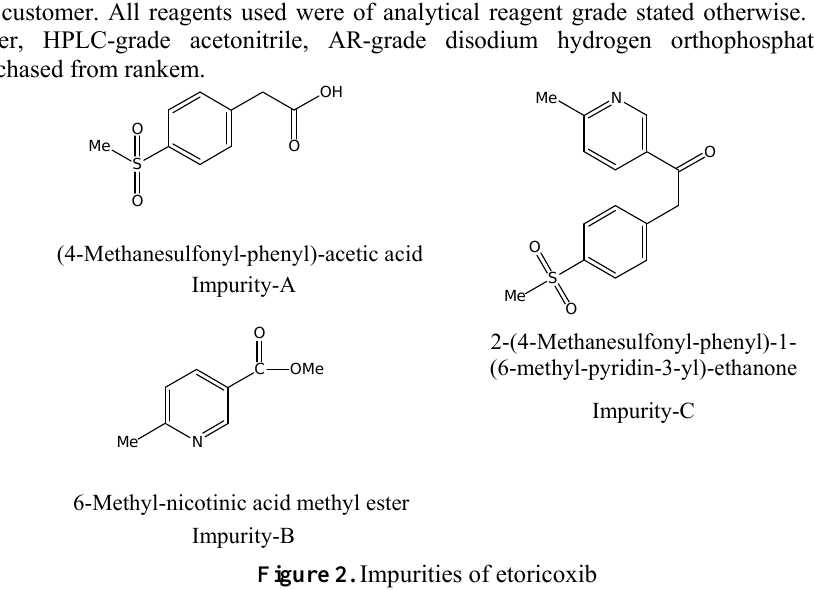
Figure 2. Impurities of